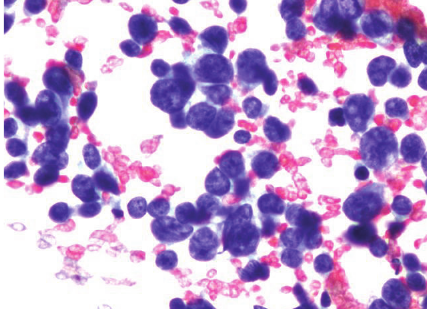
Figure 5: Small dark relatively uniform nuclei with indistinct cytoplasm.